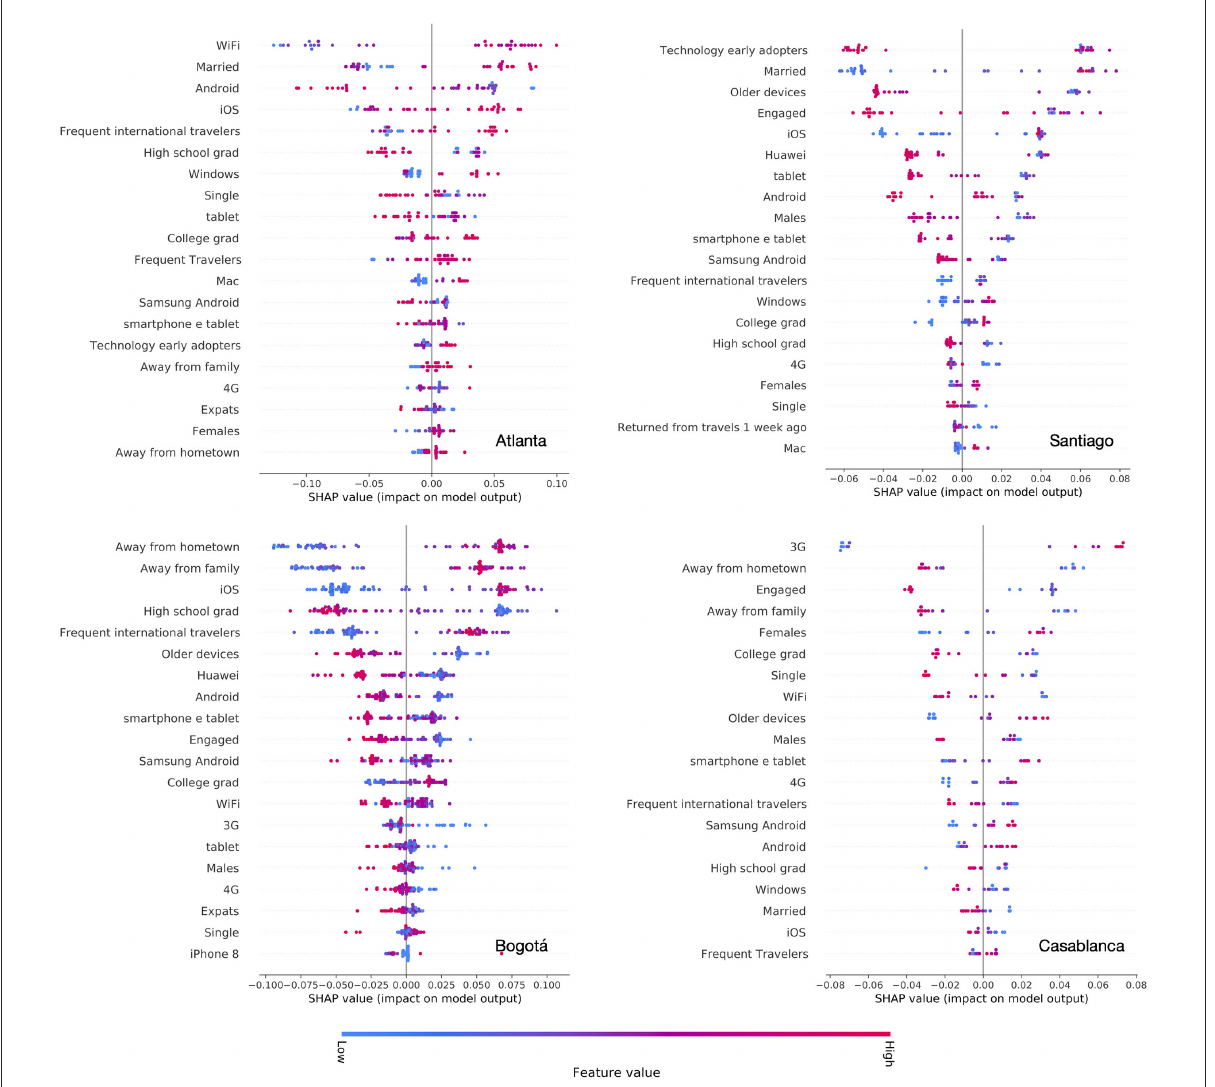
FIGURE4 SHAP plots of feature importance. For each city, we plot a summary of the effects of the top 20 features, ranked by their importance. Color represents the feature value (blue is low and red is high). The SHAP value, on the horizontal axis, indicates the feature importance on the model output, with larger values corresponding to higher